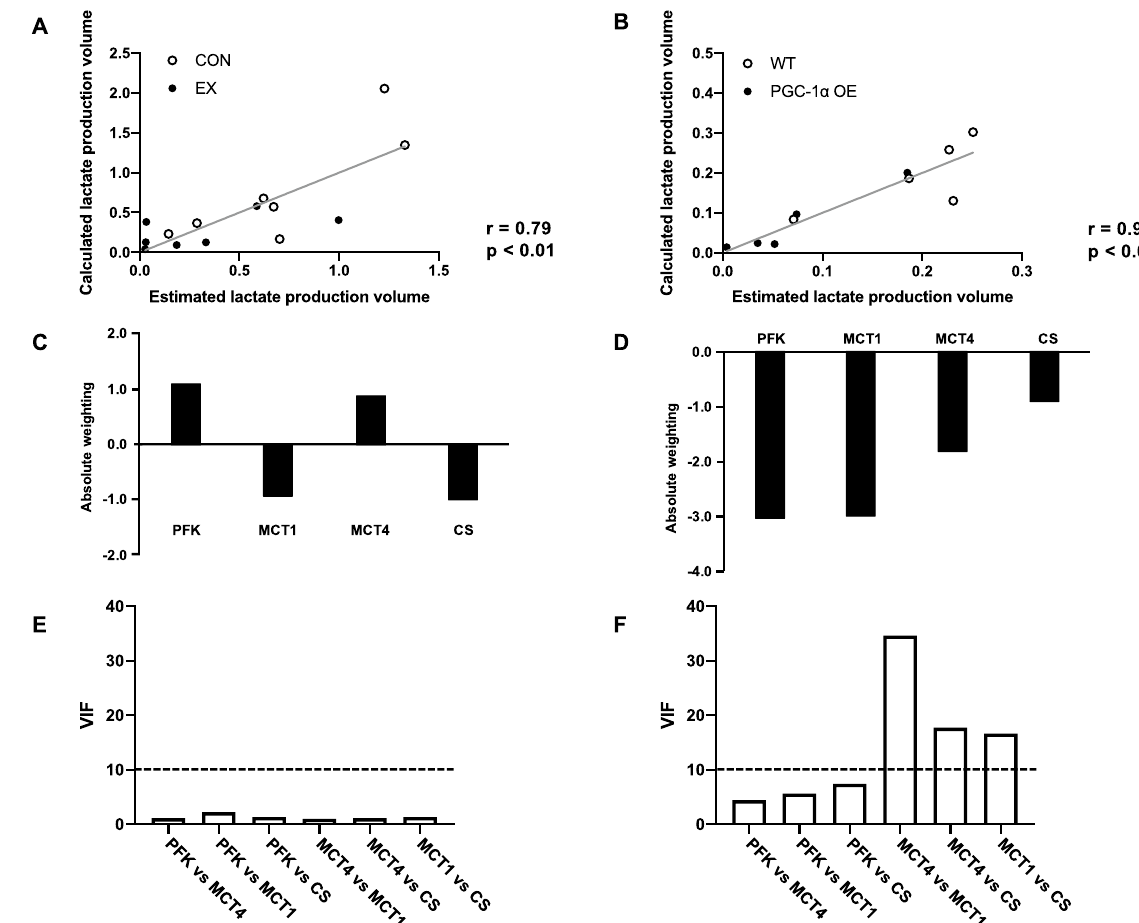
Figure 5. Relationship between lactate production volume and proteins involved in lactate metabolism. The multiple linear regression model of lactate production volume with PFK and MCT proteins and CS activity in CON and EX ( A ) and WT and PGC-1α OE ( B ). Absolute positive or negative weighting of each variable in determining lactate production volume in CON and EX ( C ) and WT and PGC-1α OE ( D ). VIF between variables in CON and EX ( E ) and WT and PGC-1α OE ( F